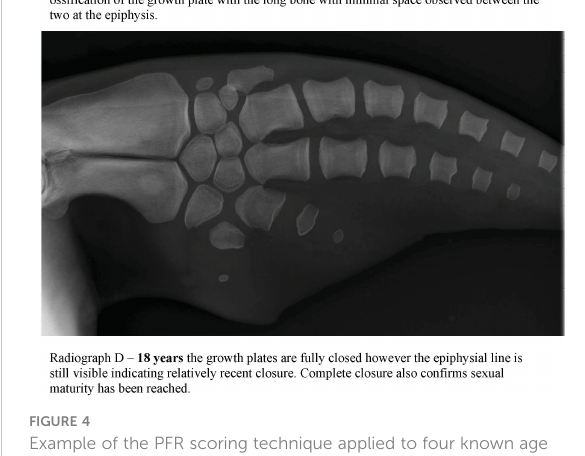
FIGURE 4 Example of the PFR scoring technique applied to four known age female